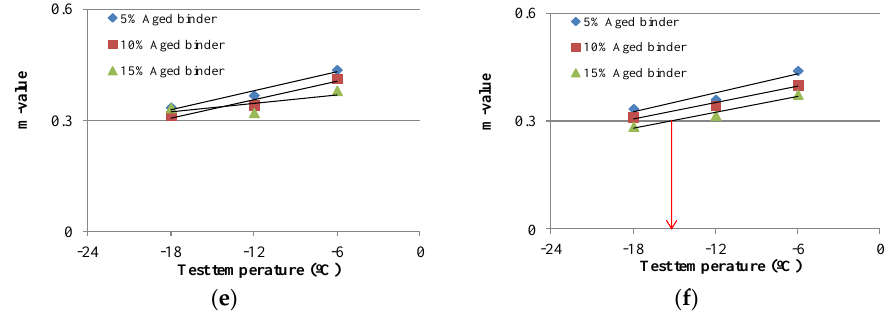
Figure 6. Low temperature determinations of RAP sources A–F with RTFO binder PG 58-22 in terms of m-value, ( a – f ) RAP sources A–F.